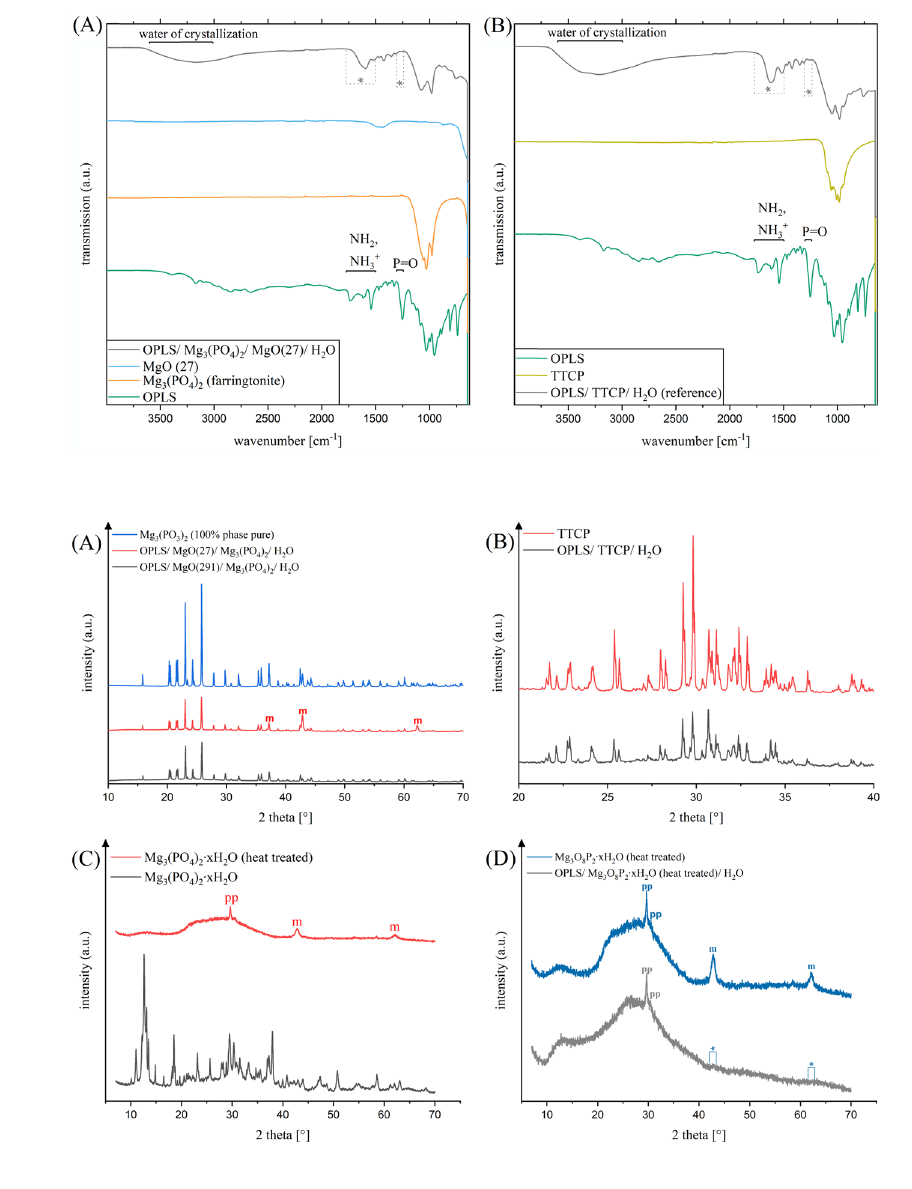
Fig. 4 FTIR transmission spectra (incl. FTIR of the reactant powders) at the wave range of 4000 to 650 cm − 1 of: ( A ) OPLS/ Mg 3 (PO 4 ) 2 / MgO(27)/ H 2 O. B OPLS/ TTCP/ H 2 O (reference)